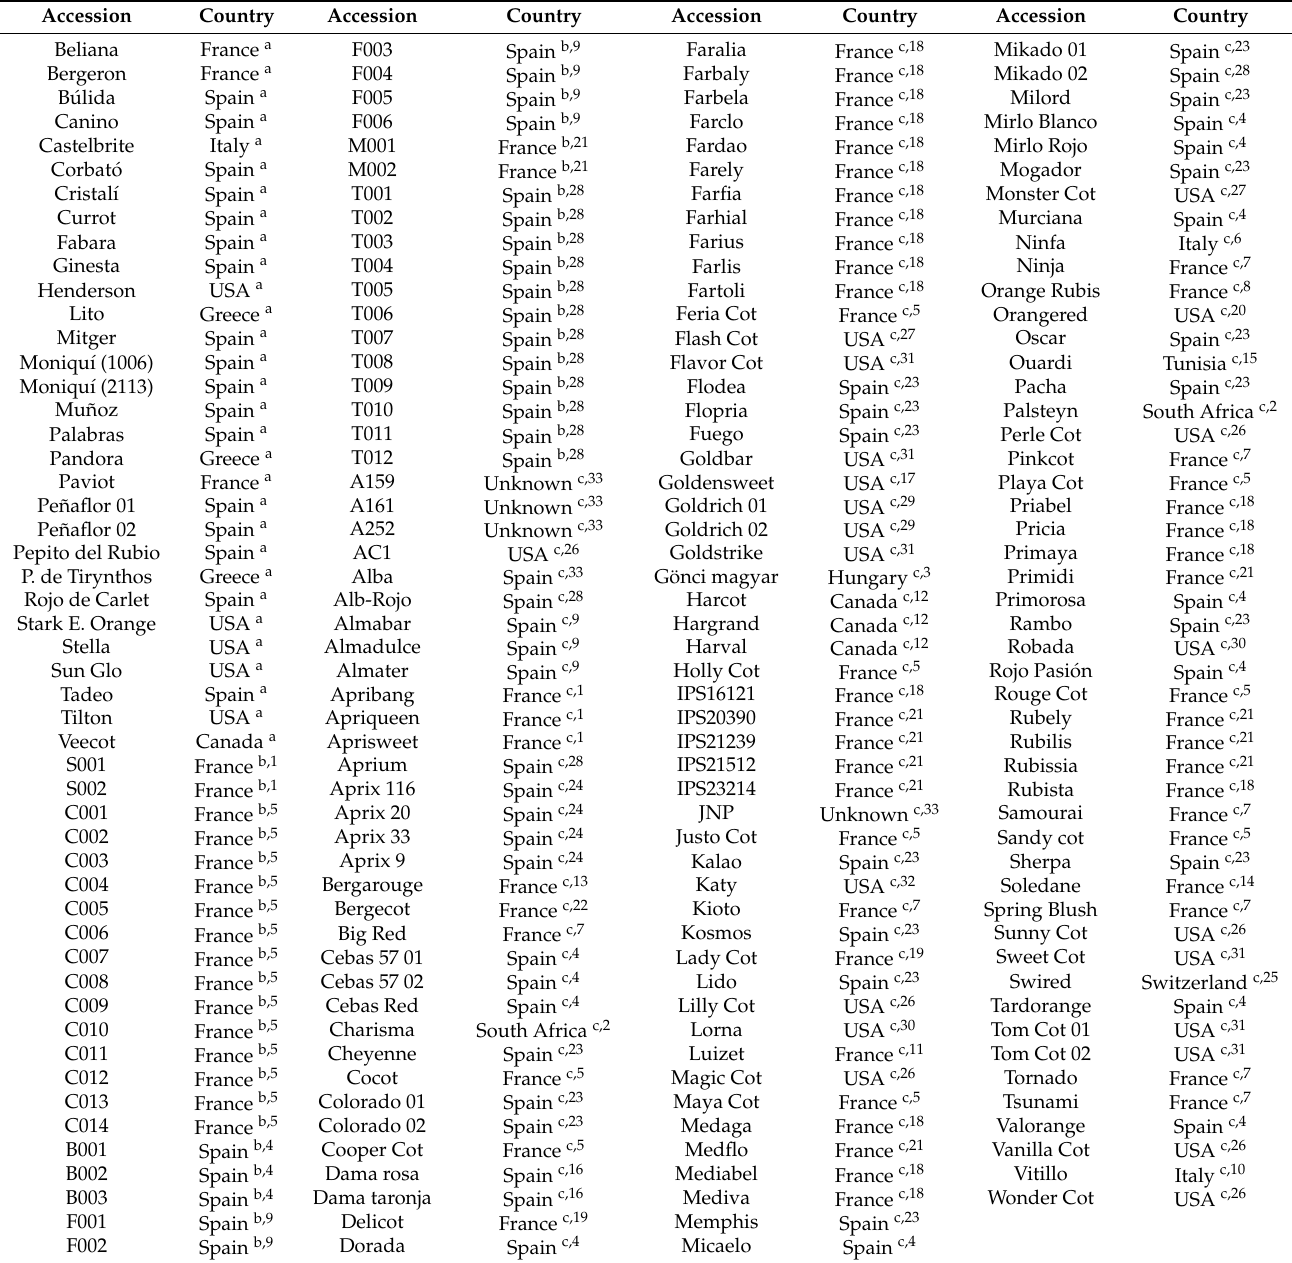
Table 1. Origin of the 201 apricot accessions and one interspecific hybrid (aprium) analyzed in this study.